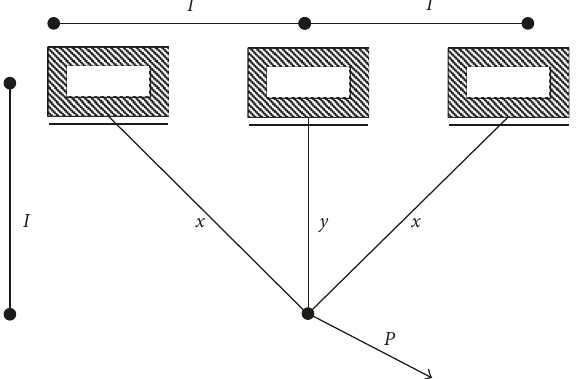
Figure 7: Three truss bar design problem.